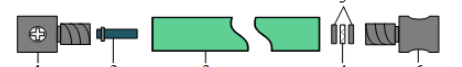
Figure 2. Cross-sectional diagram of cracking pipe: (1) charging valve; (2) heating element; (3) tube; (4) constant stress shearing sheet; (5) seal rings; (6) release storage tube; (4) constant stress shearing sheet; (5) seal rings; (6) release hole.